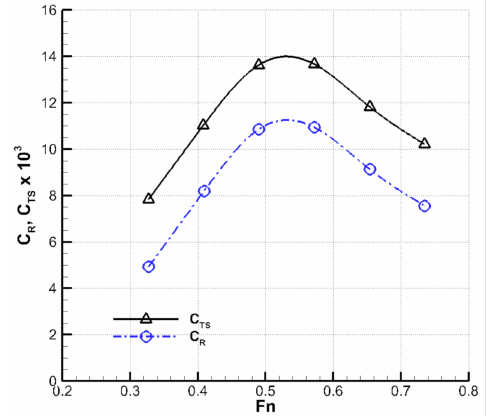
Figure 4. Total resistance coefficient C TS and residuary resistance coefficient C R obtained from the model